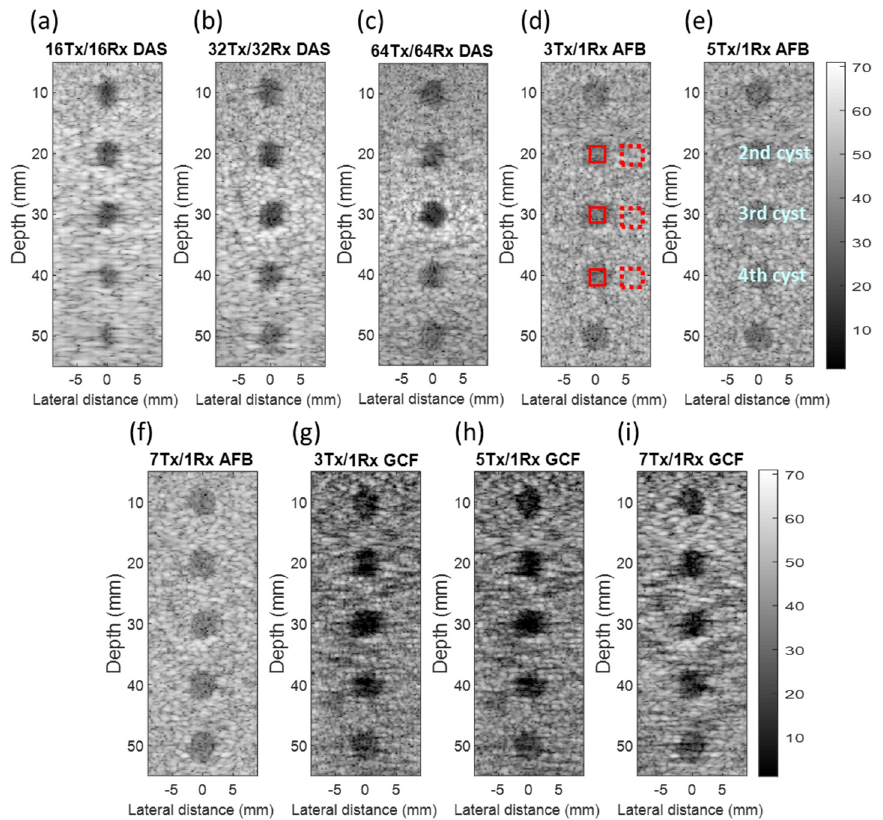
Figure 6. Five anechoic cysts simulation results of nine methods. ( a ) 16 Tx/16 Rx DAS. ( b ) 32 Tx/32 Rx DAS. ( c ) 64 Tx/64 Rx DAS. ( d ) 3 Tx/1 Rx AFB. ( e ) 5 Tx/1 Rx AFB. ( f ) 7 Tx/1 Rx AFB. ( g ) 3 Tx/1 Rx GCF. ( h ) 5 Tx/1 Rx GCF. ( i ) 7 Tx/1 Rx GCF.